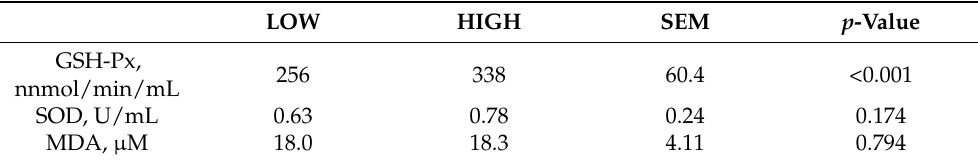
Table 3. Effect of maternal dietary antioxidant level on activity of antioxidative enzymes in plasma of off-springs at day 25 of age (LOW: n = 26 piglets; HIGH: n = 27 piglets; Mean and standard error of mean (SEM)).